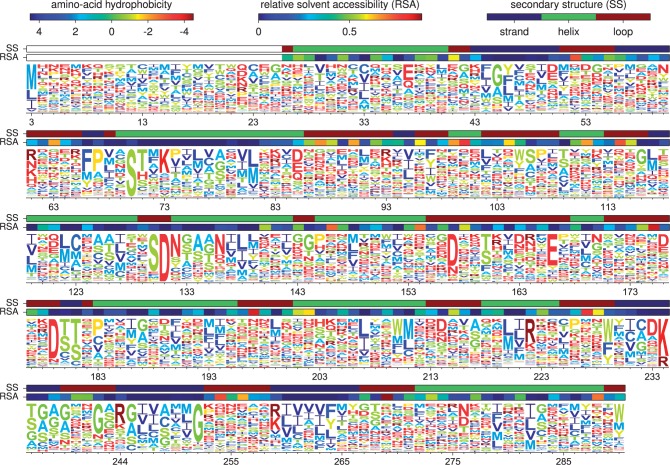
The amino acid preferences for TEM-1
beta-lactamase, calculated from the data of Firnberg et al. (2014). The heights of
letters are proportional to the preference for that amino acid at
that position in the protein. Residues are numbered using the scheme
of Ambler et al.
(1991). Letters are colored according to the hydrophobicity
of the amino acid. Bars above the letters indicate the secondary
structure and relative solvent accessibility as calculated from the
crystal structure in PDB entry 1XPB (Fonzé et al. 1995) using DSSP
(Kabsch and Sander
1983; Joosten et
al. 2011), with maximum solvent accessibilities taken
from Tien et al.
(2013). The figure was generated using
“WebLogo” (Crooks
et al. 2004) integrated into the “mapmuts”
software package (Bloom
2014). The data and source code used to create this plot
are provided through http://jbloom.github.io/phyloExpCM/example_2014Analysis_lactamase.html
(last accessed July 28, 2014).